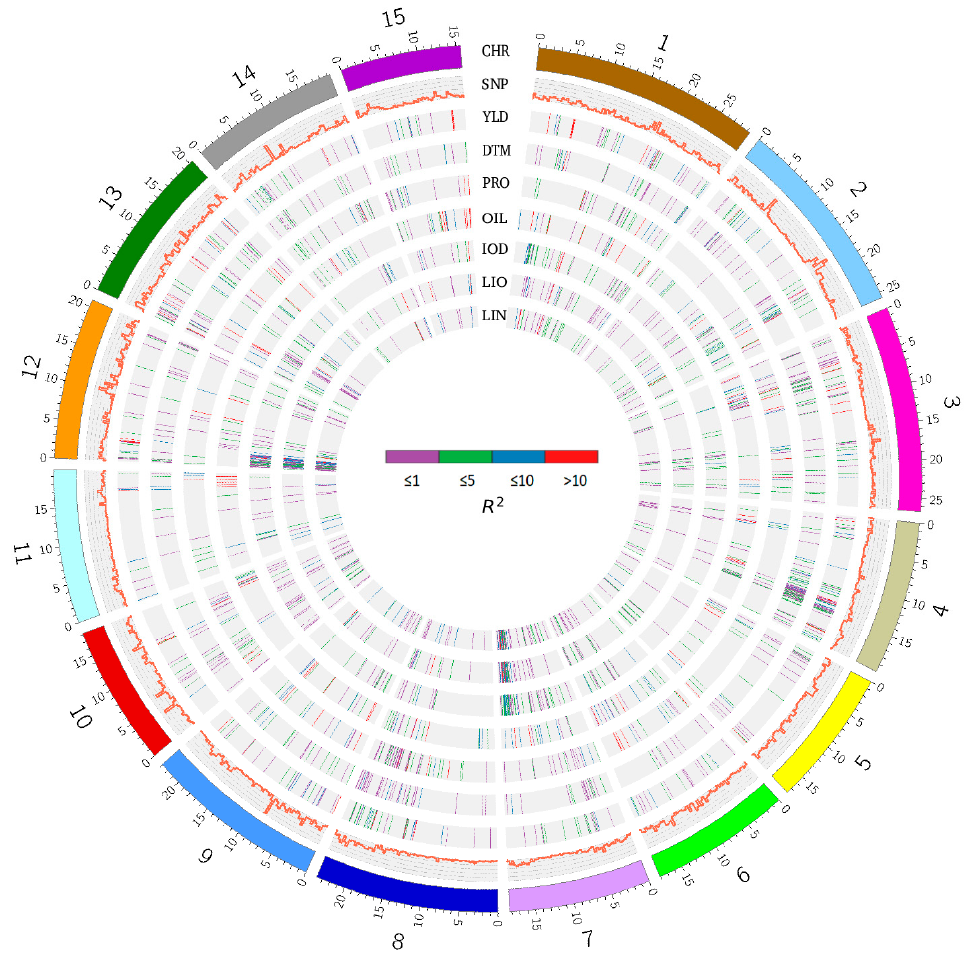
Figure 2. Circos map of quantitative trait nucleotides (QTNs) associated with seven traits in the 260 lines. Track 1 (from outer), chromosomes; Track 2, density of 17,277 SNPs (bin size of 300 kb); Track 3, QTNs for YLD; Track 4, QTNs for DTM; Track 5, QTNs for PRO; Track 6, QTNs for OIL; Track 7, QTNs for IOD; Track 8, QTNs for LIO; Track 9, QTNs for LIN. The effects of QTNs are represented by different colors. R 2 ≤ 1%, purple; 1% < R 2 ≤ 5%, green; 5% < R 2 ≤ 10%, blue; R 2 > 10%, red. YLD, seed yield; DTM, days to maturity; PRO, protein content; OIL, oil content; IOD, iodine value; LIO, linoleic acid content; LIN, linolenic acid content; SNP, single nucleotide polymorphism.